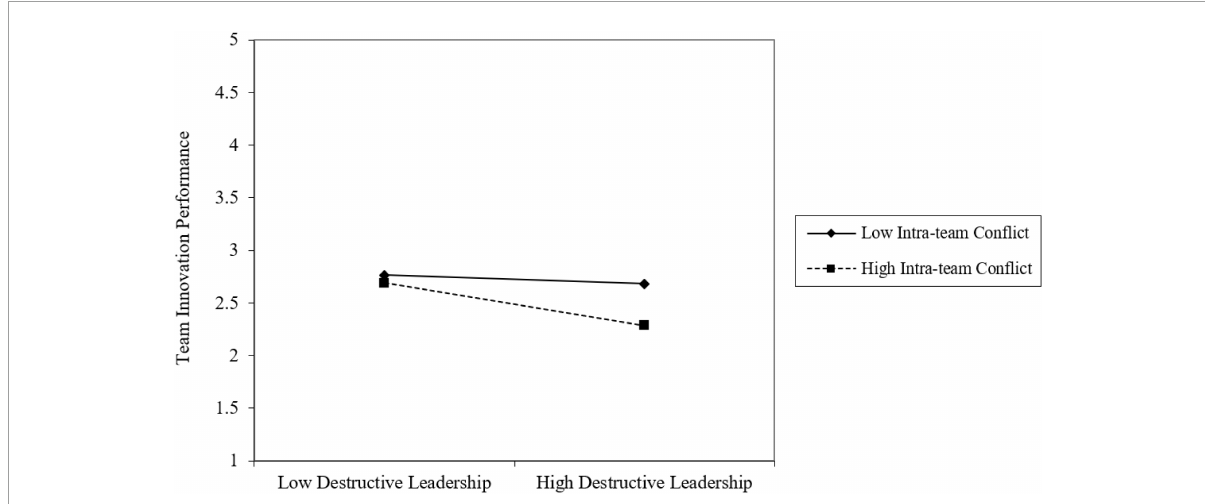
FIGURE2 Moderating effect of intra-team conflict on the relationship between destructive leadership and team innovation performance.